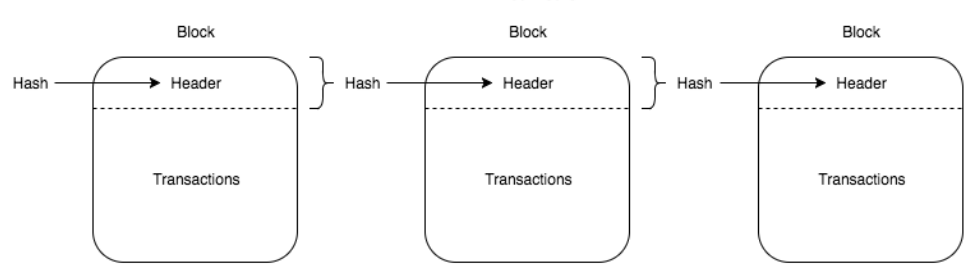
Figure 6. This diagram illustrates the general architecture of a blockchain, blocks of data that are interlinked by using the hash of the last block as the header of the next one